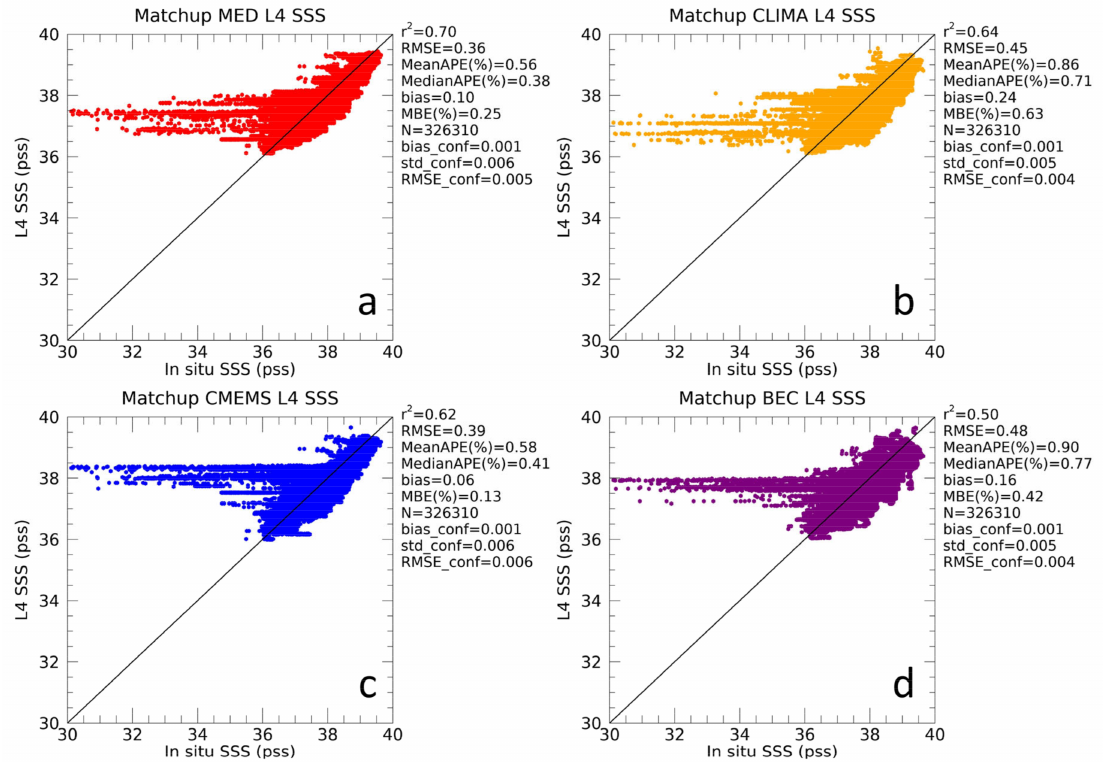
Figure 4. Scatterplots of the validation against the independent in situ dataset. Comparison of the observed against interpolated L4 SSS values, for the four different L4 SSS datasets: new Med L4 SSS ( a ); in situ climatology ( b ); CMEMS L4 SSS ( c ); BEC L4 SSS ( d ). In each panel, the statistics of the validation for each satellite dataset are